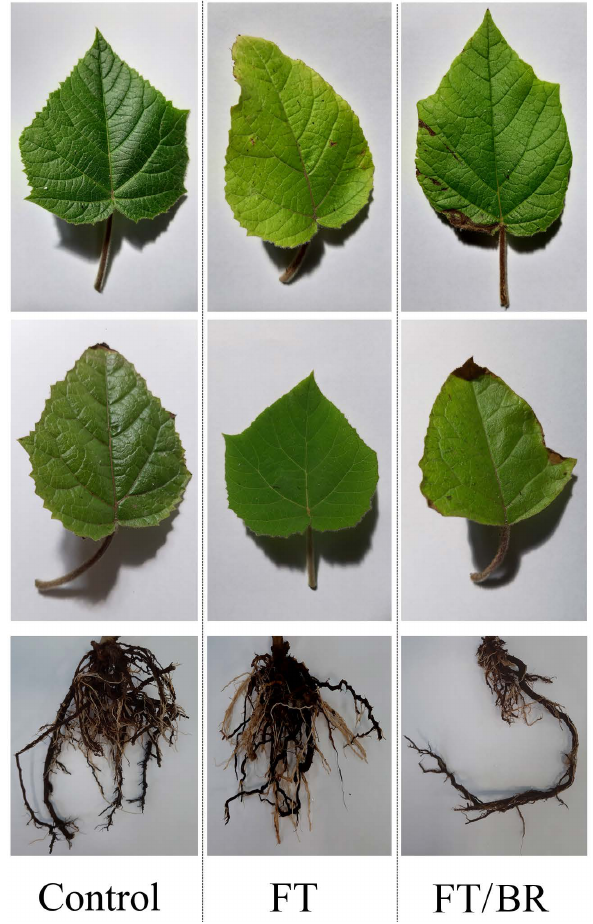
Figure 3. Leaves and roots of Paulownia after second year of the